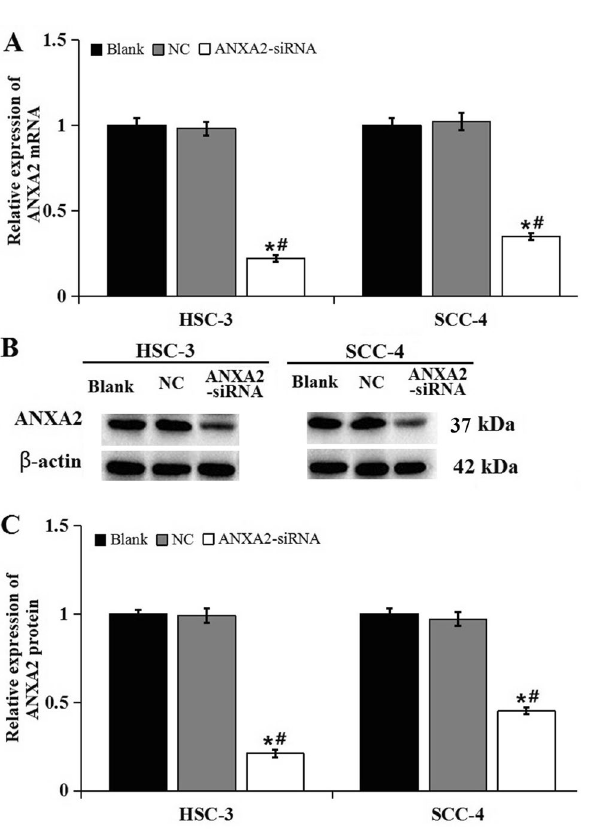
Figure 3. The mRNA and protein expression levels of ANXA2 in NOK, HSC-3, SCC-4 and CAL27. ( A ) RT-PCR showed mRNA expression of ANXA2 in the NOK, HSC-3, SCC-4 and CAL27 cells. ( B ) Western blot showed the protein expression of ANXA2 in the NOK, HSC-3, SCC-4 and CAL27 cells. ( C ) Comparison of the protein expression of ANXA2 in the NOK, HSC-3, SCC-4 and CAL27 cells. Data were presented as the mean ± SD of at least three repeated experiments. * P < 0.05, compared with NOK cells; # P < 0.05, compared with HSC-3 and SCC-4 cells.